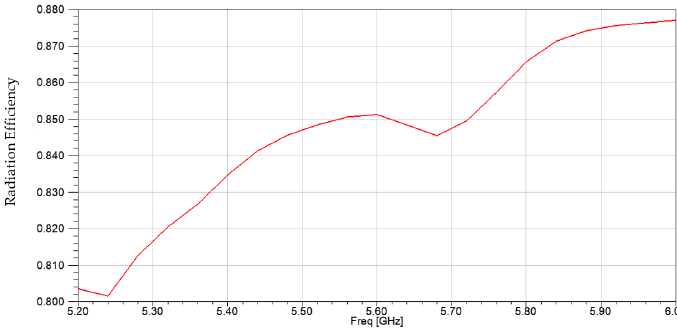
Figure 12. Gain Patterns ( a ) For Azimuth Plane ( b ) For Elevation Plane.